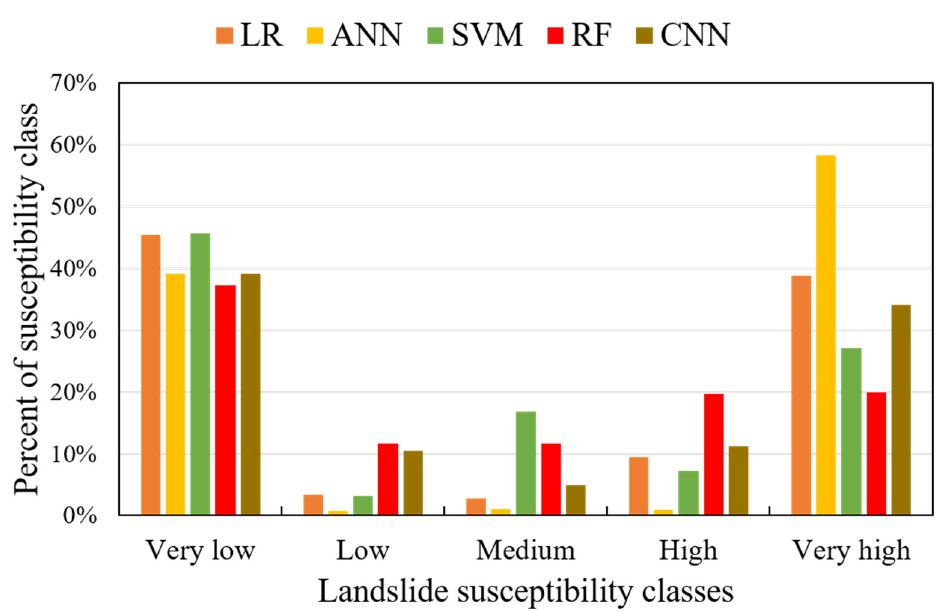
Figure 9. The distribution of each class per generated LSMs.